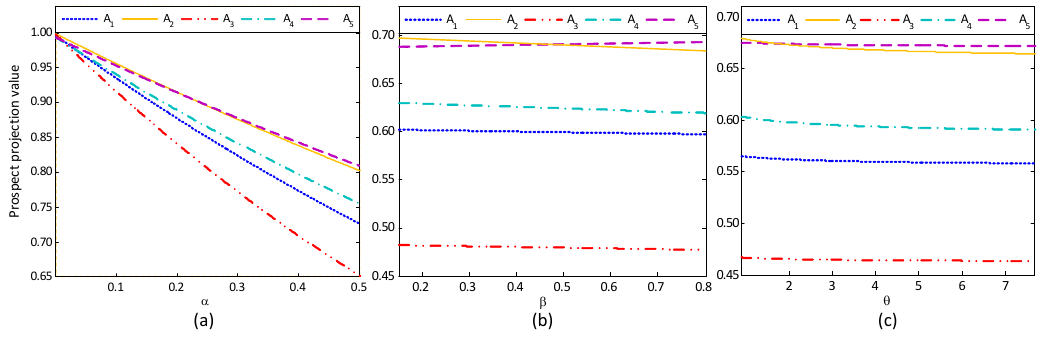
Figure 4. Sensitivity analysis of the optimal alternatives with respect to a single parameter: ( a ) α ; ( b ) β ; ( c ) θ .